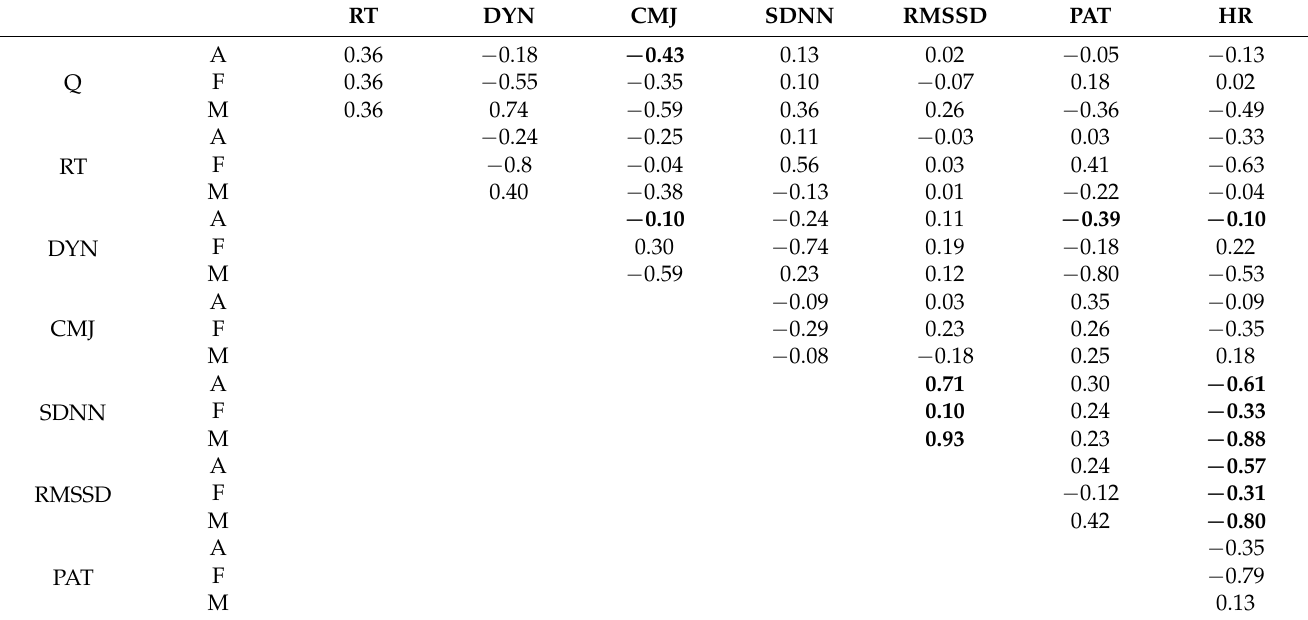
Table 5. Linear correlation coefficient values between different parameters based on the whole study group (A), male subgroup (M) and female subgroup (F). Parameter values are taken as the difference in % between those in the rested state and physically-fatigued state. Q—questionnaire, RT—reaction time, DYN—dynamometer hand grip force, CMJ—countermovement jump height, SDNN—HRV parameter SDNN, RMSSD—HRV parameter RMSSD, PAT—pulse arrival time and HR—average heart rate (between the resting heart rate and average veloergometer cycling heart rate). Values above 0.5 or below − 0.5 are marked in